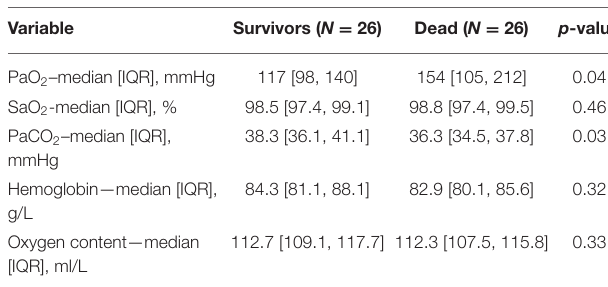
TABLE 3 | Oxygenation and carbon dioxide removal